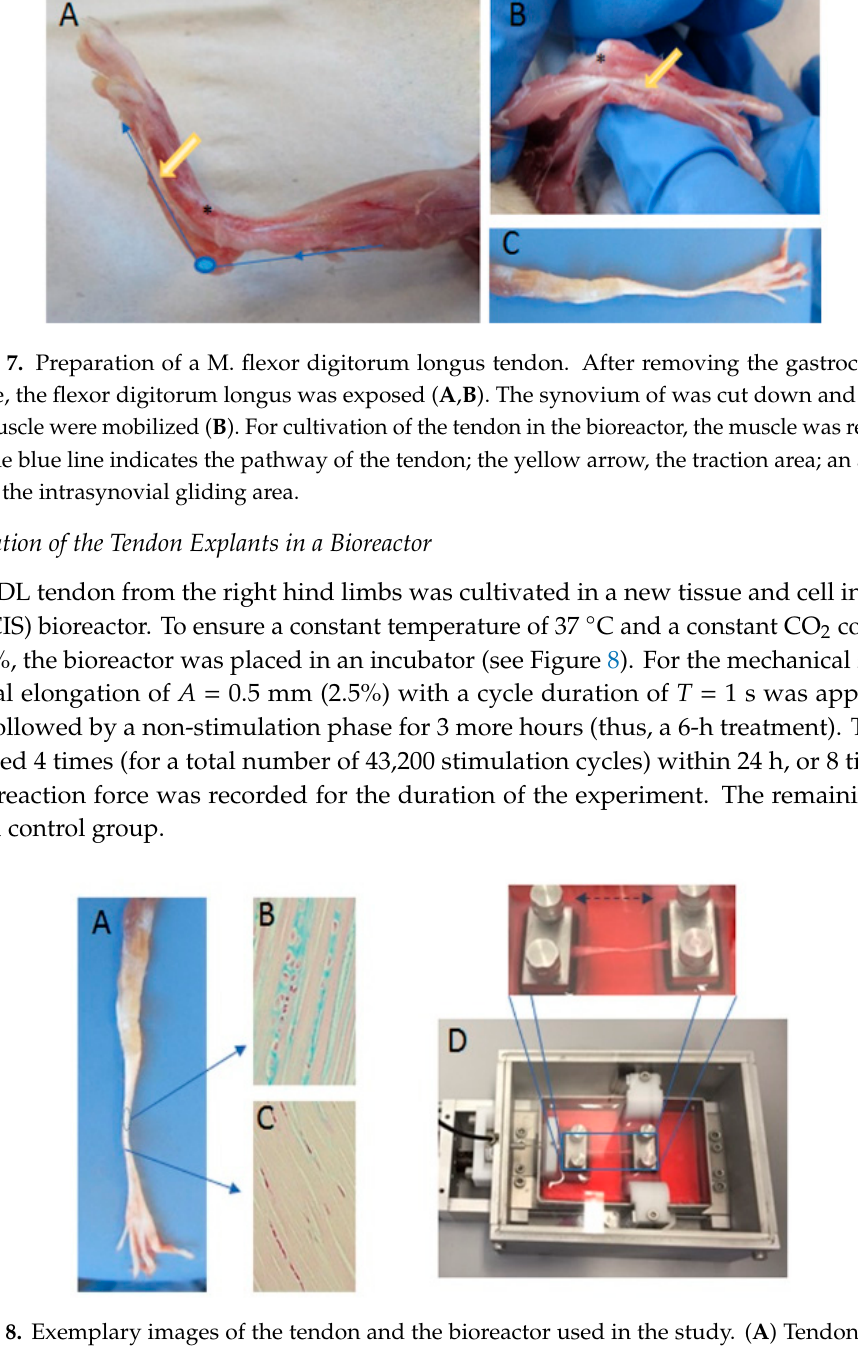
Figure 8. Exemplary images of the tendon and the bioreactor used in the study. ( A ) Tendons of the flexor digitorum longus were extracted from rat legs with two different areas of traction and gliding and stained with an Alcian blue to indicate the varying expression of sulfated glycosaminoglycans (sGAG) in different areas of the tendon (gliding ( B ) and traction ( C )). ( D ) The image shows the in vitro bioreactor that was used, in which the tendon was fixed between two pads.